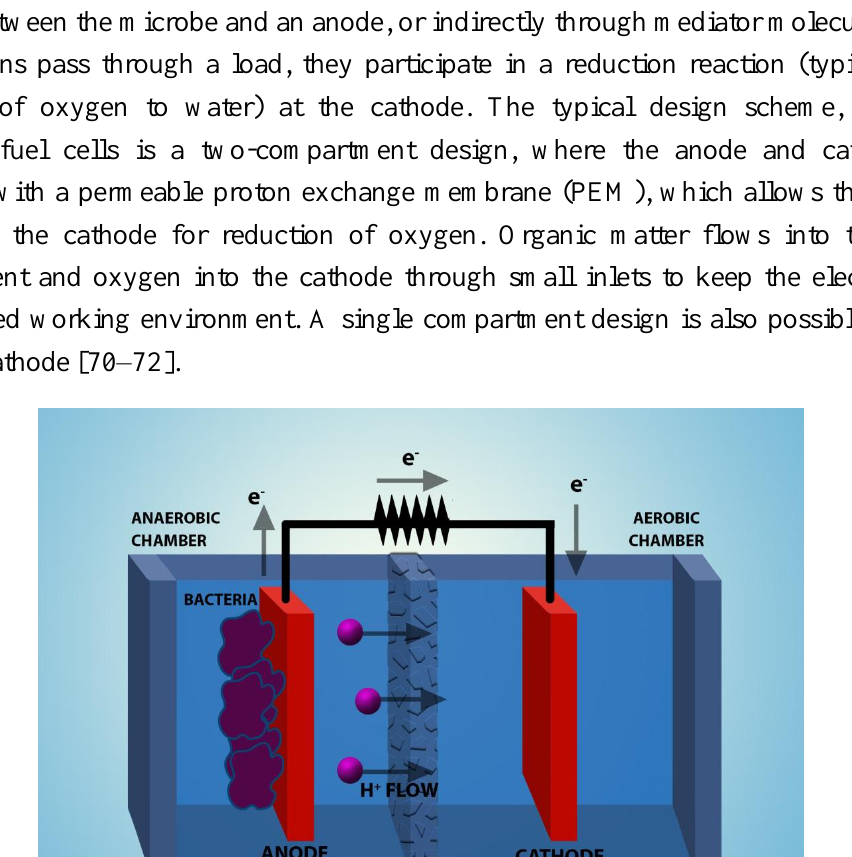
Figure 6. Microbial fuel cell schematic. Microbial fuel cells utilize microbes to